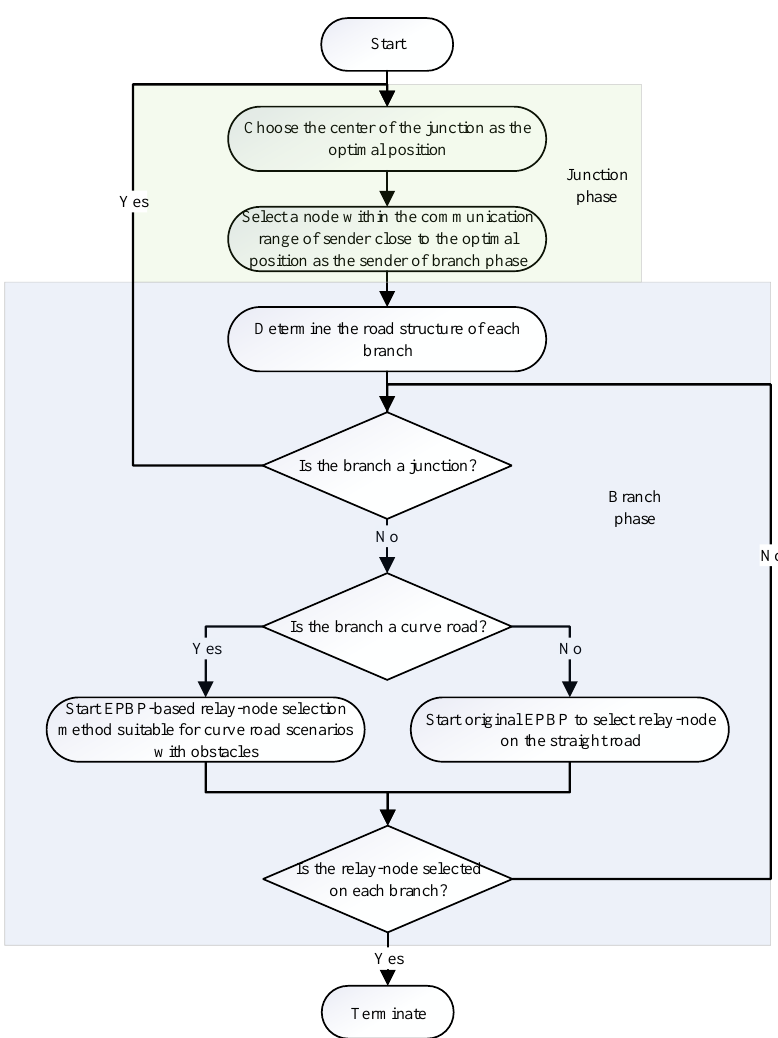
Figure 2. Flow diagram of the improved exponent-based partitioning broadcast protocol (EPBP)-based junction relay-node selection.